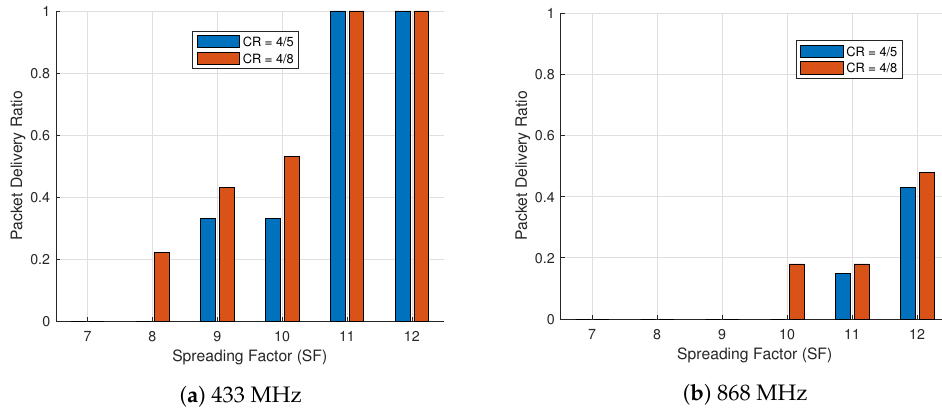
Figure 13. PDR vs. SF varying the CR in POS 3 ( a ) 433 MHz ( b ) 868 MHz. At a higher code rate, the improved forward error correction (FEC) allows more bits to be recovered: fewer packets are corrupted and discarded by the CRC, thus resulting in a higher PDR . An example is demonstrated in Figure 13a,b, which shows that for an SF value of 8 in the 433 MHz and SF value of 10 in the 868 MHz both in POS 3, communi- cation was only possible when using the highest level of redundancy ( CR = 8 ) . Despite this, the connectivity was patchy, with only a small fraction of packets being delivered successfully, close to 22% and 18% respectively. No communication was impossible for an SF value of 12 at POS D, irrespective of the CR value. It should be noted that, in almost all tested configurations, even though it is not reported, that the measured SNR for each packet, despite that better PDR is marginally but still significantly lower, using a